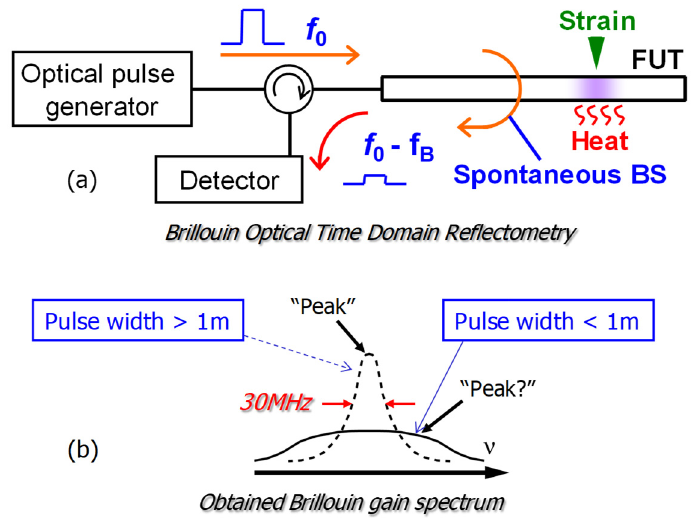
Figure 18. Schematic drawing of Brillouin optical time-domain reflectometry through launching a pulsed lightwave and detecting Brillouin backscattering as a function of time ( a ). Origin of trade-off between the spatial resolution (pulse width) and the measurement accuracy of strain and/or temperature (line width of the pulse) ( b ).